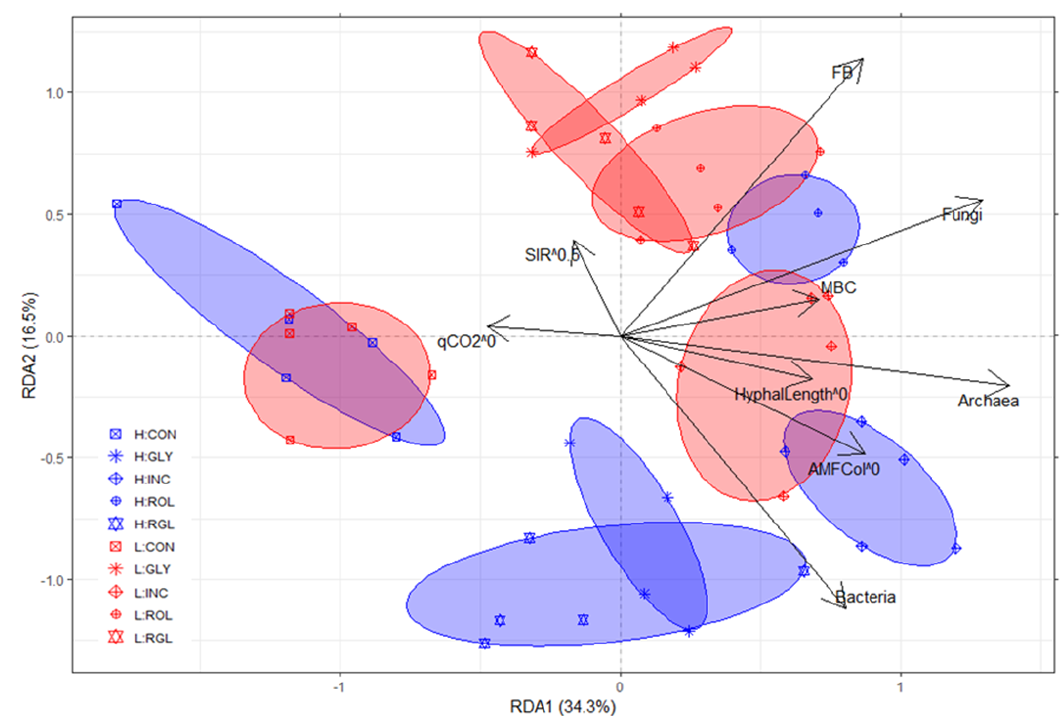
Figure 3. Redundancy analysis (RDA) results at 57 DAS maize for soil microbial variables and ten combined treatments of termination methods and water levels. CON: control, INC: mowing + incorporating, GLY: glyphosate, RGL: glyphosate + roller, ROL: roller crimper; H: high water level, L: low water level; qCO2: metabolic quotient, SIR: substrate induced respiration, Col: AMF colonization, MBC: microbial biomass carbon.